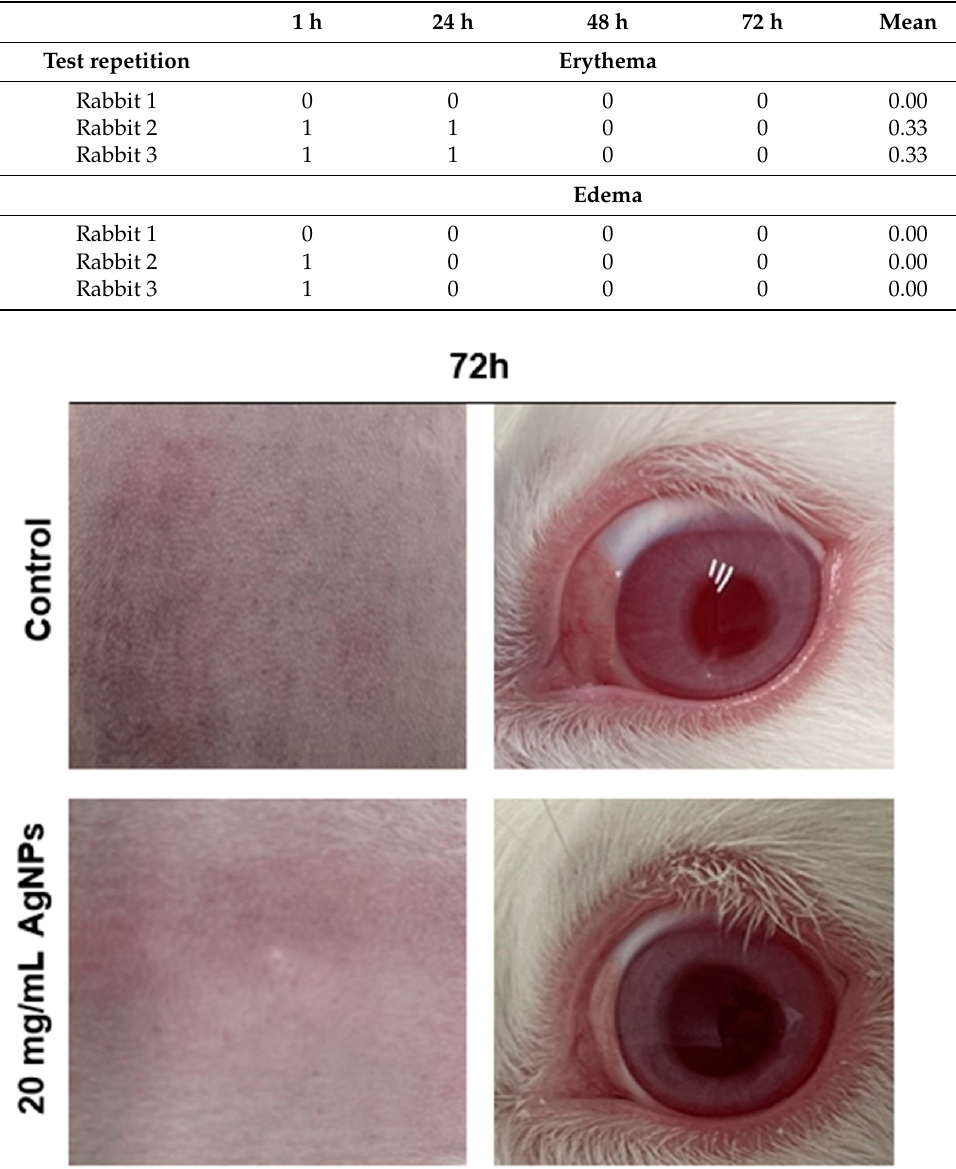
Figure 2. Rabbit dermal and ocular response 72 h after 20 mg/mL AgNPs treatment.